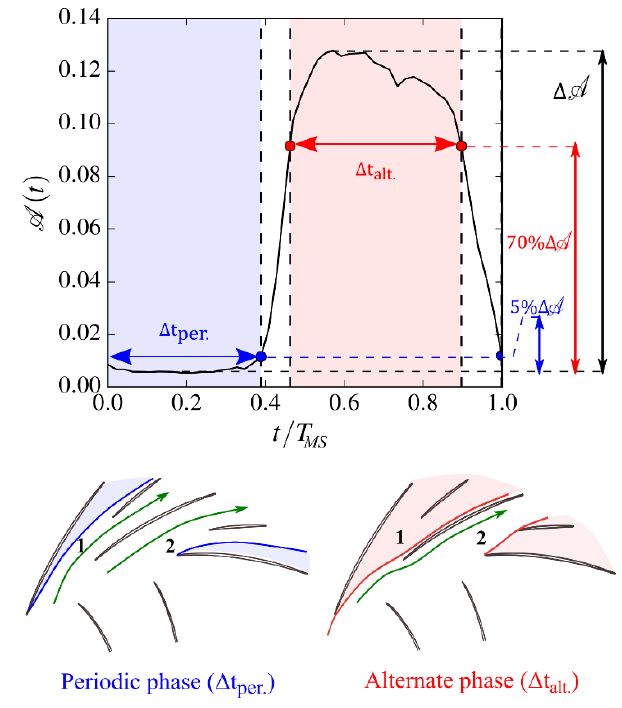
Figure 10. Cutting of a mild surge period according to the alternate rate: periodic phase and alternate phase.